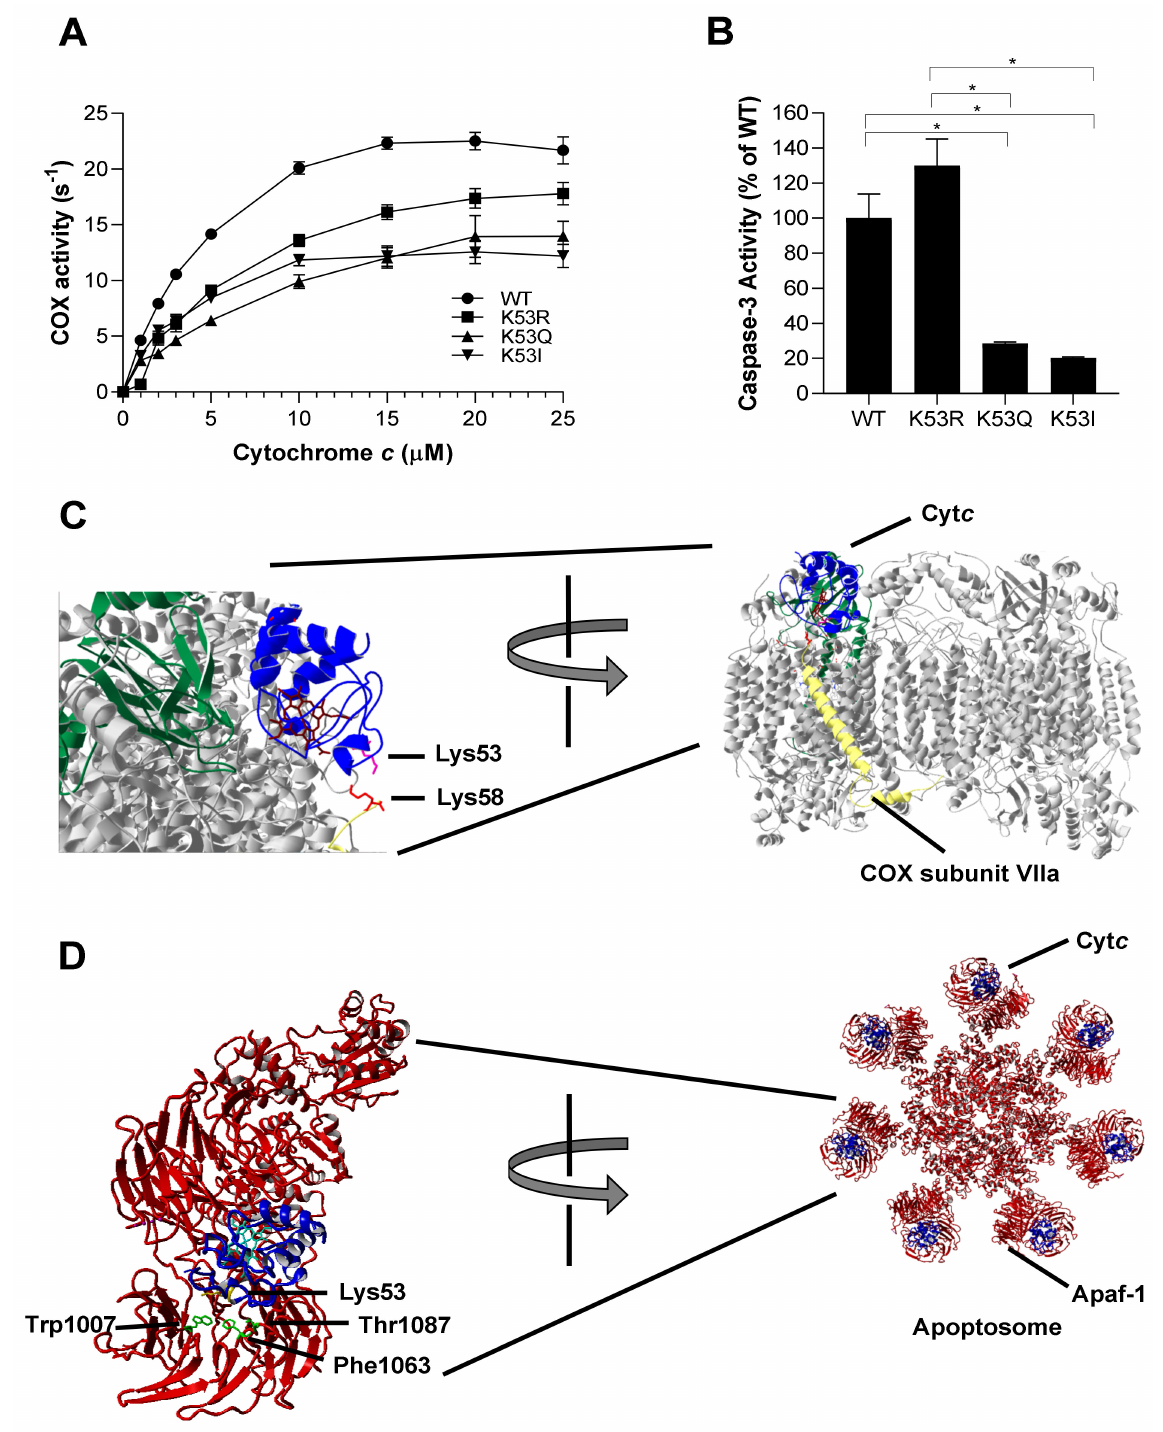
Figure 2. ( A ) Oxygen consumption rate was measured in the presence of 30 nM of bovine liver COX using an Oxygraph system. WT, K53R, K53Q, and K53I Cyt c variants were titrated at concentrations of 0, 1, 2, 3, 5, 10, 15, 20, and 25 µ M ( n = 3). Data are represented as means ± SEM. ( B ) Cytosolic extracts of HeLa cells were incubated with recombinant WT, K53R, K53Q, and K53I variants for 2.5 h at 37 ◦ C. Fluorescence that resulted from caspase-3 mediated cleavage of the rhodamine substrate DEVD-R110 was used as a measure of caspase-3 activity ( n = 3). Data are represented as means ± SEM, * p < 0.05. ( C ) Docking model of COX and Cyt c [32] showing the interaction of Lys53 residue of Cyt c with Lys58 residue of COX subunit VIIa within 5 Å. ( D ) Cyt c Lys53 interaction with Apaf-1 represented on the human apoptosome structure [33]. Apaf-1 residues Phe1063 (within 5 Å) and Trp1007 and Thr1087 (within 6 Å) are in close proximity to Lys53